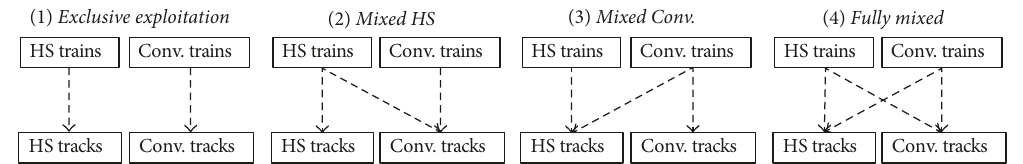
Figure 2: Four types of HSR models adapted from [18], where HS represents high-speed and Conv. represents conventional.